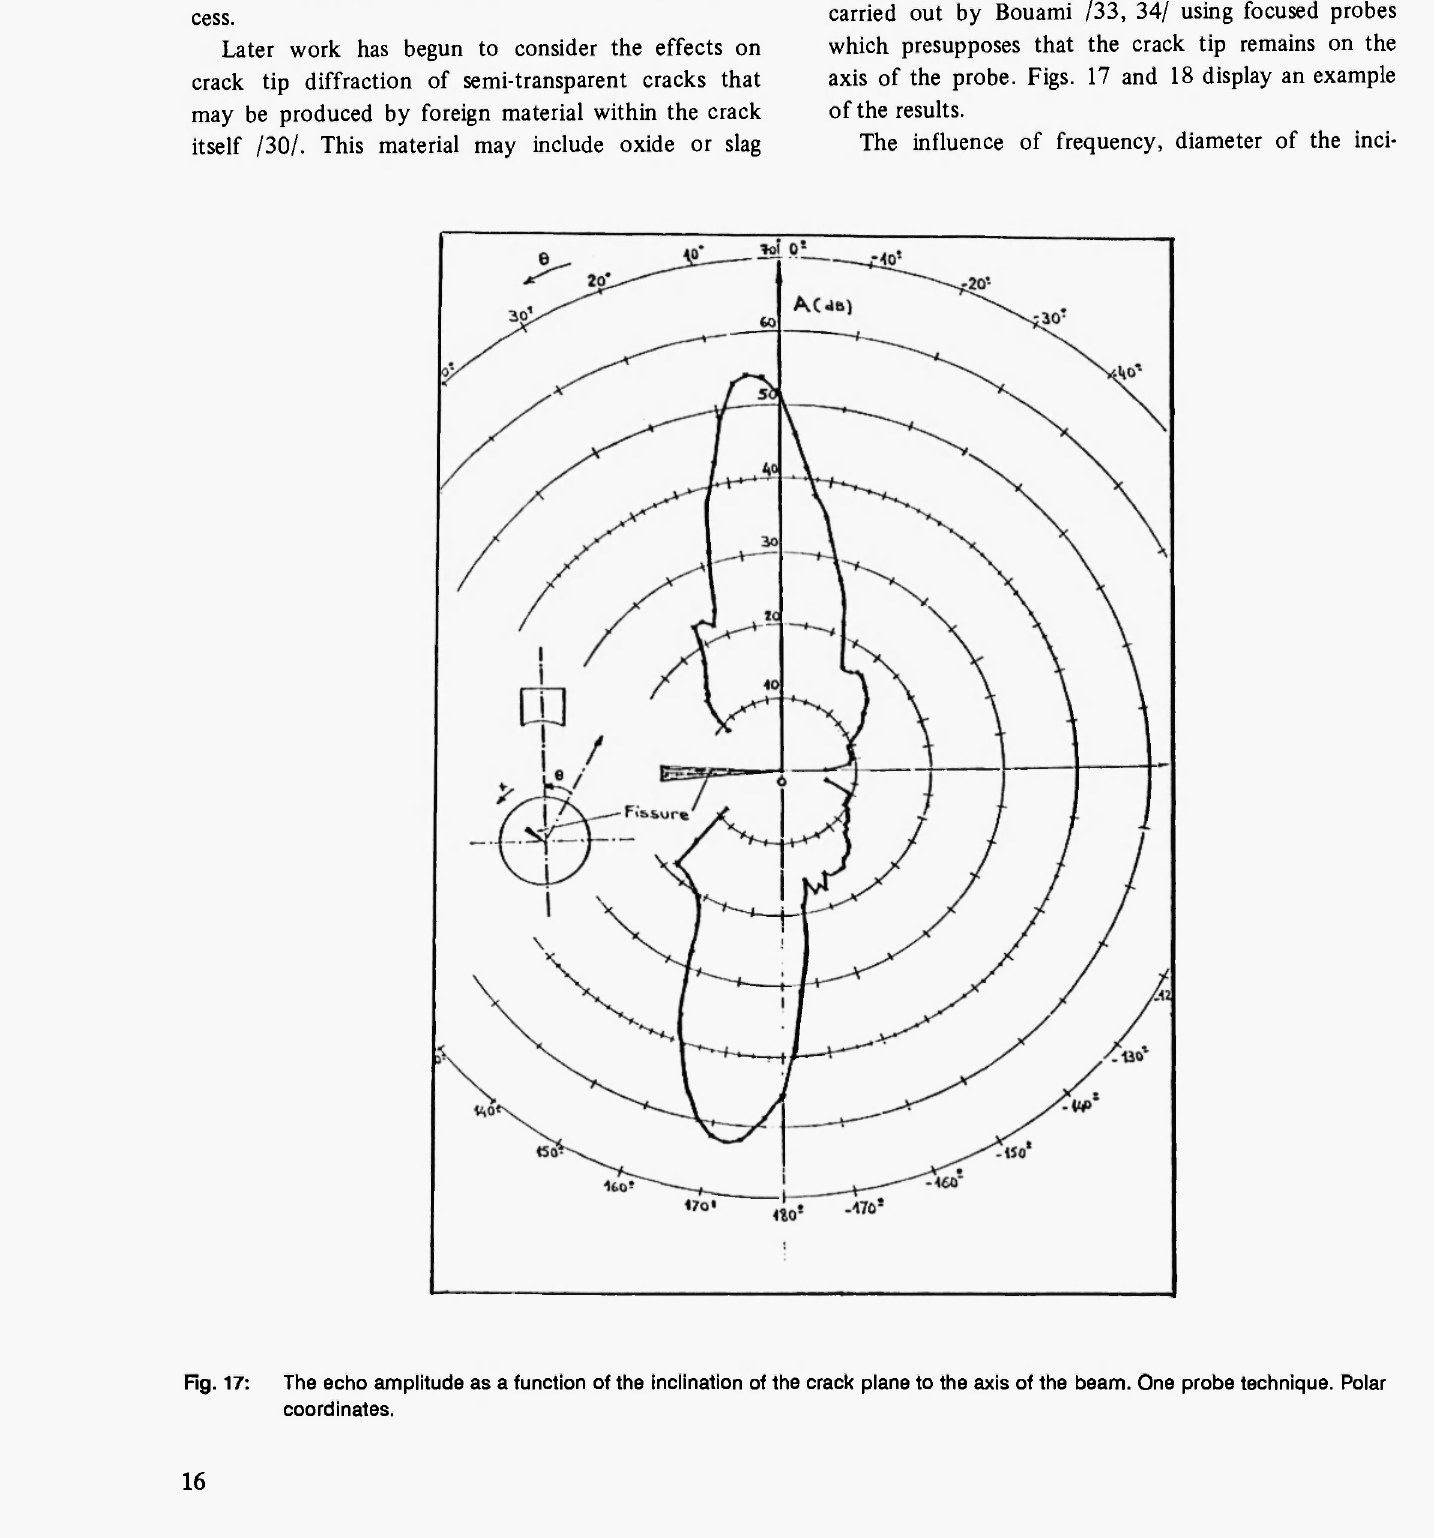
Fig. 17: The echo amplitude as a function of the Inclination of the crack plane to the axis of the beam. One probe technique. Polar